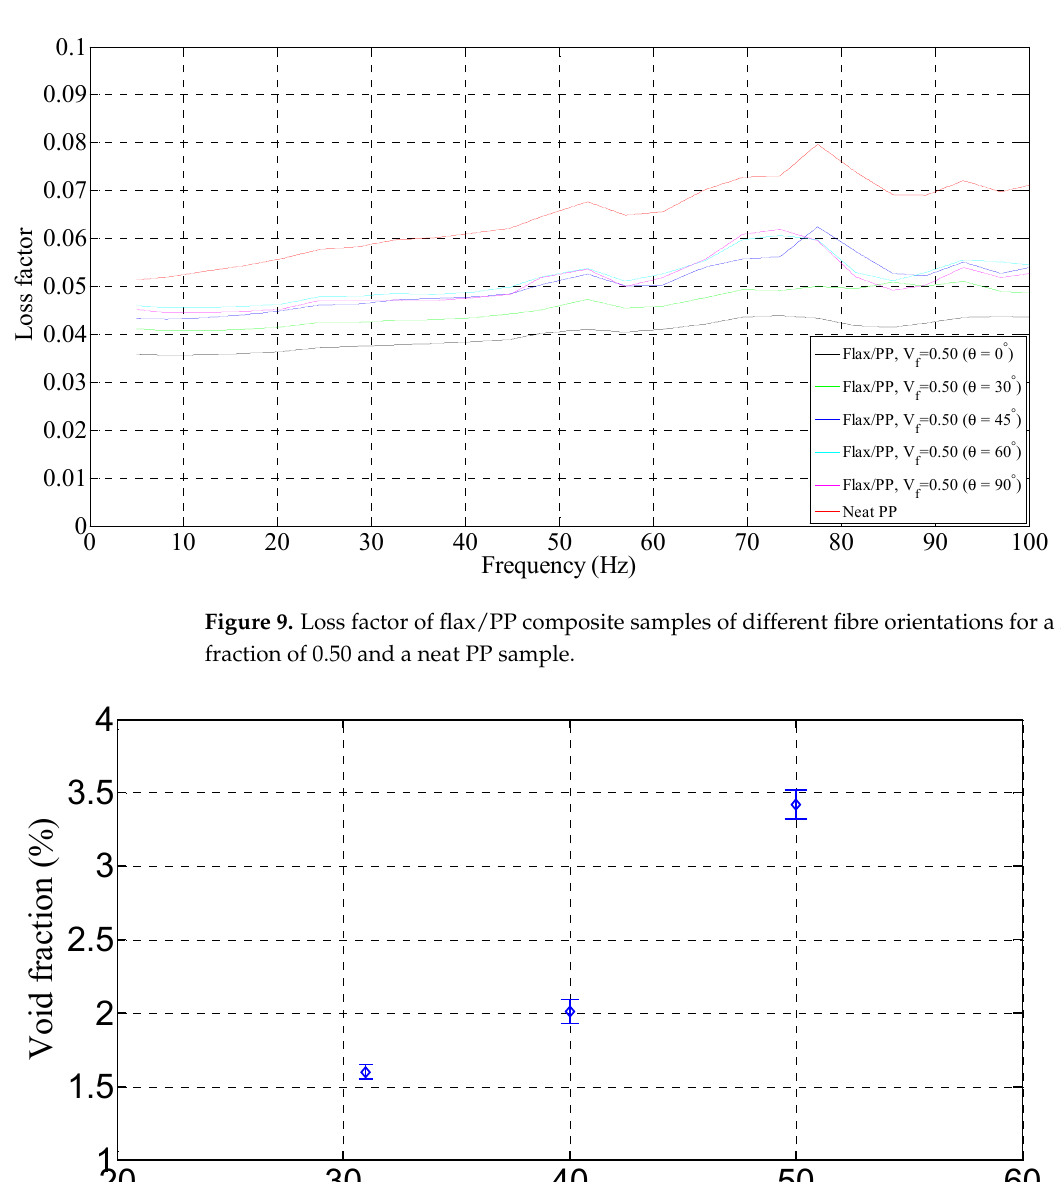
Figure 8. Loss factor of flax/PP composite samples of different fibre orientations for a fibre volume fraction of 0.40 and a neat PP sample.